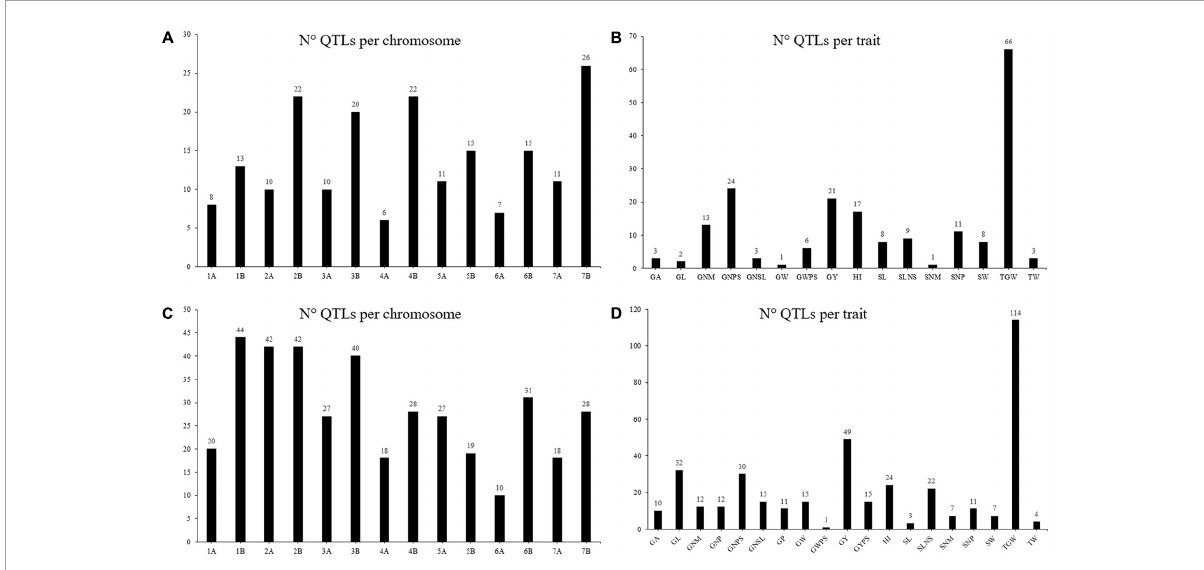
FIGURE3 Number of QTL projected under different water regimes. Number of projected QTL per chromosome (A) and per trait (B) under irrigated conditions. Number of projected QTL per chromosome (C) and per trait (D) under rainfed